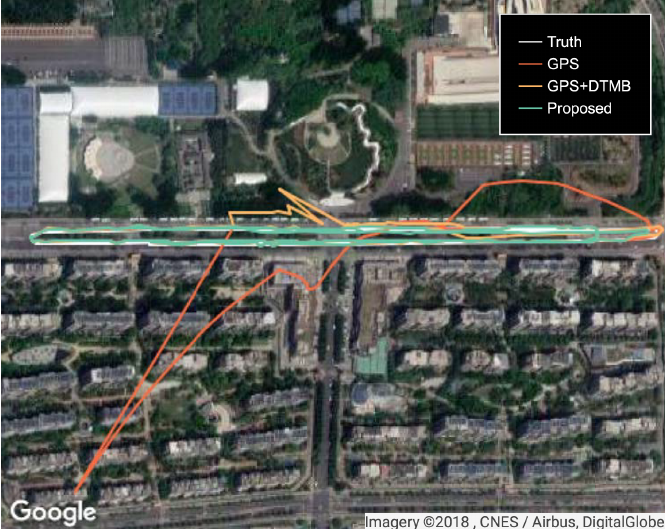
Figure 23. Trajectories generated from true positions and positioning results at Site